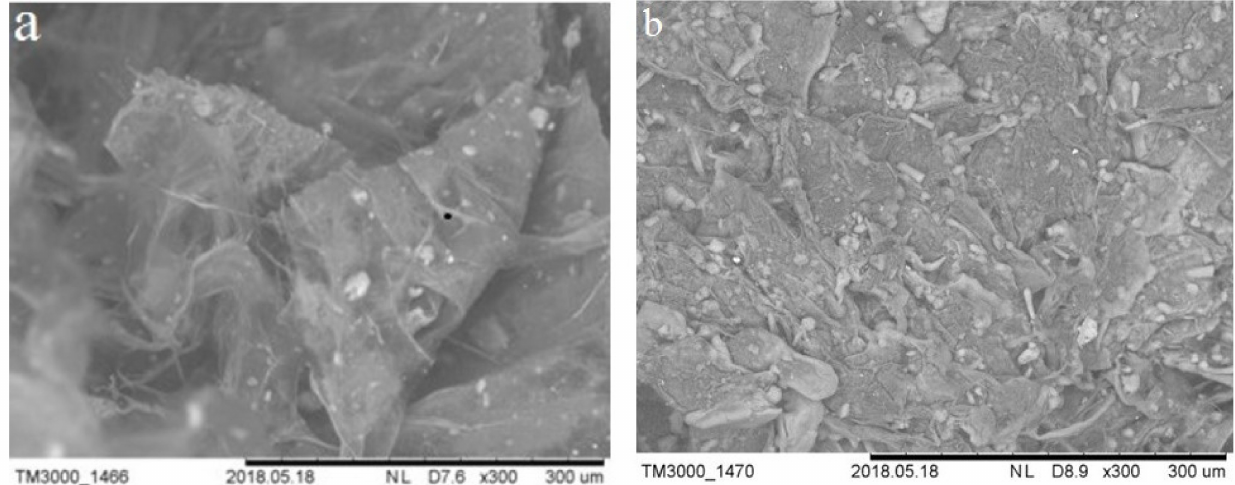
Figure 7. ( a ) SEM image of BC at 300 magnification; ( b ) SEM image of BC modified with aluminum oxide at 300